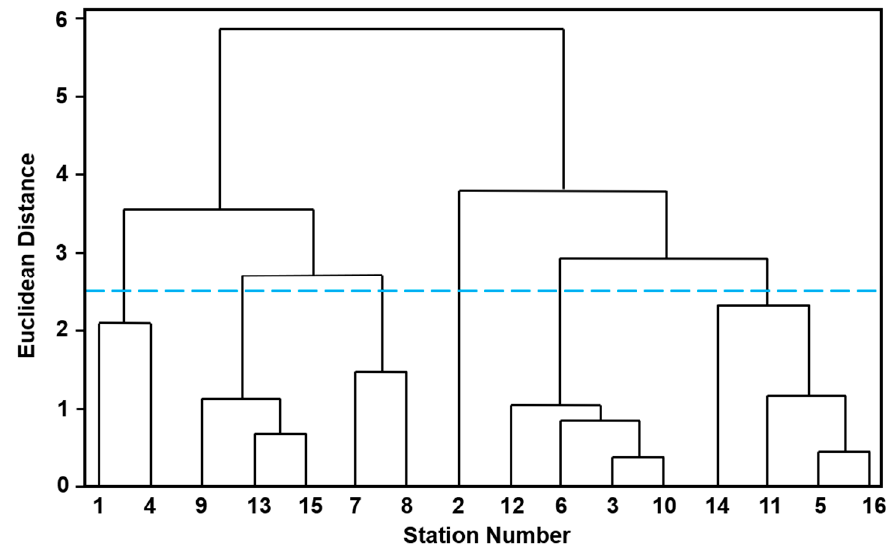
Figure 5. Hierarchical clustering results of the Tianjin water quality monitoring stations (the blue line represents the location where the Euclidean distance was equal to 2.5).